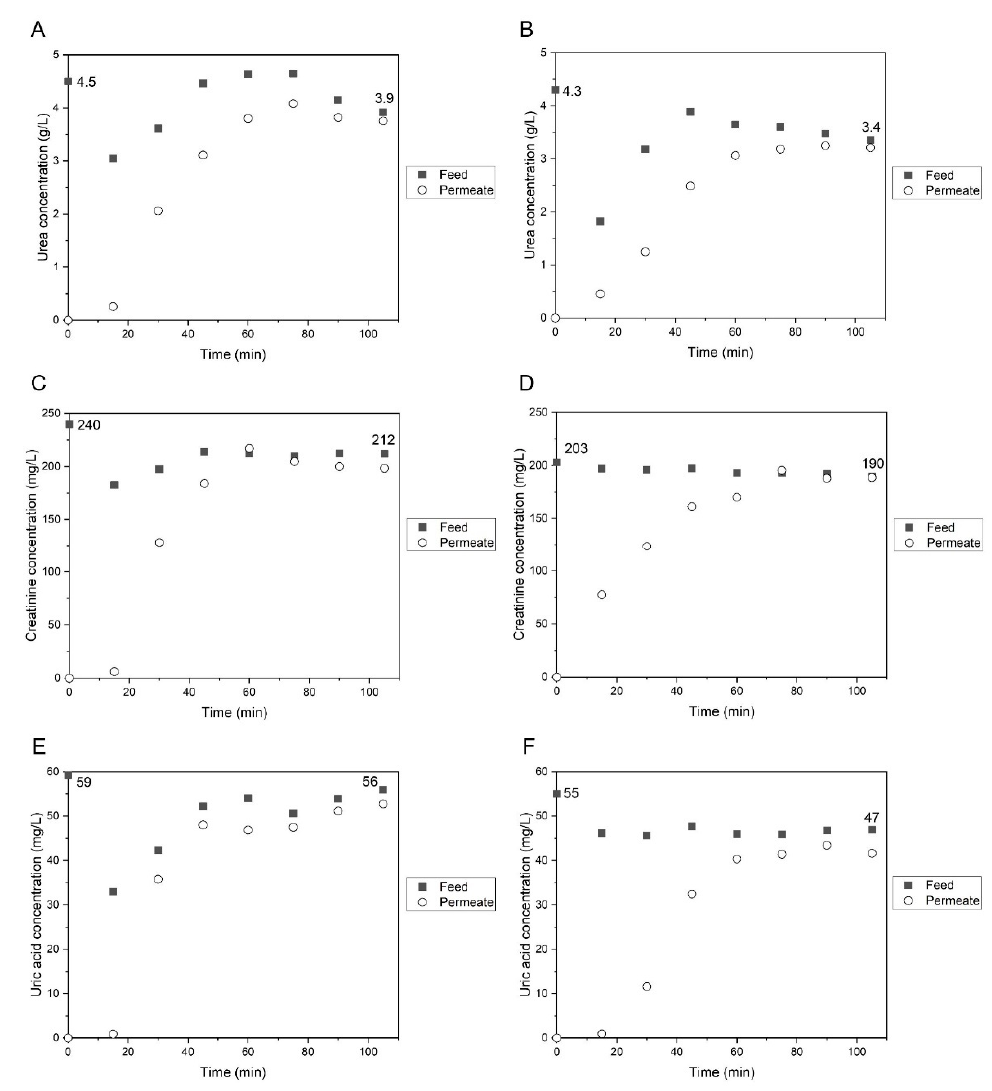
Figure 9. Concentration profiles of urea, creatinine, and uric acid for CA-SiO 2 -(CH 2 ) 3 NH 2 ( A , C , E ) and CA ( B , D , F ) membranes, regarding feed ( ■ ) and permeate ( ○ ) samples, for a total experiment time of 90 min. The initial feed concentrations aim to represent those of uremic populations.